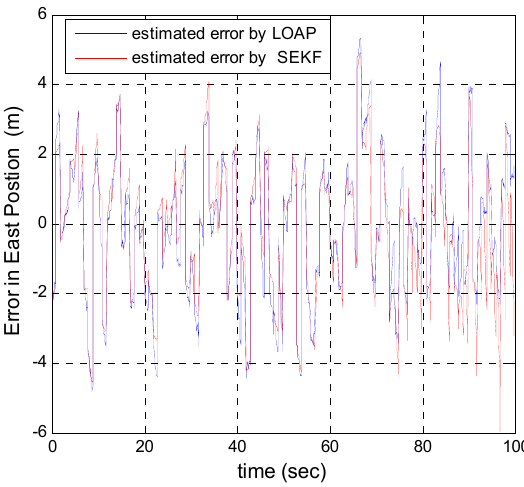
Figure 6. Error estimation of east position.